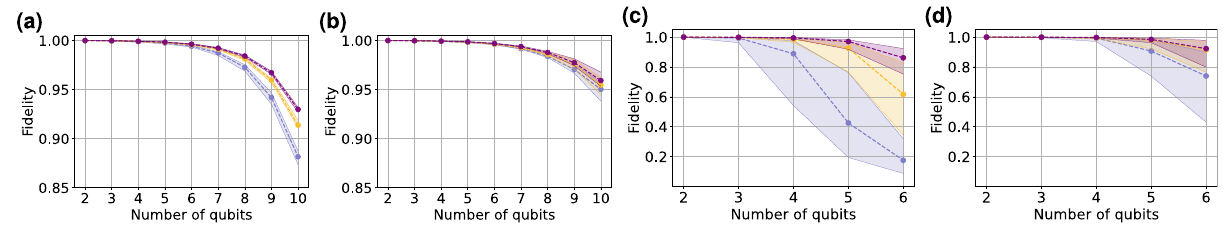
Fig. 2 Median fi delity between arbitrary states and its estimates as a function of the number of qubits. a, c Arbitrary randomly generated states reconstructed with local bases and entangled bases, respectively. b, d Local randomly generated states reconstructed with with local bases and entangled bases, respectively. The colors label the number of bases: For a and b we have 2 n + 1 (blue), 3 n + 1 (yellow), and 4 n + 1 (purple) local bases. For c and d we have 2 (blue), 3 (yellow), and 4 (purple) entangled bases plus the computational basis. Shaded areas represent the corresponding interquartile